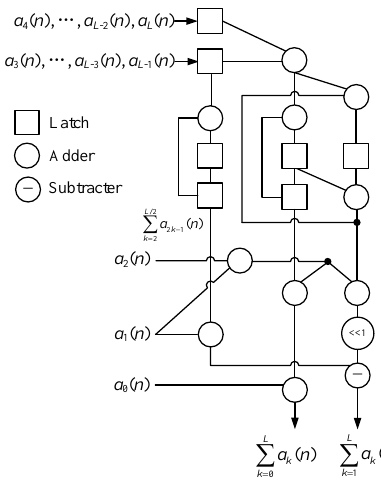
Figure 4. The improved computational structure for first-order moment.